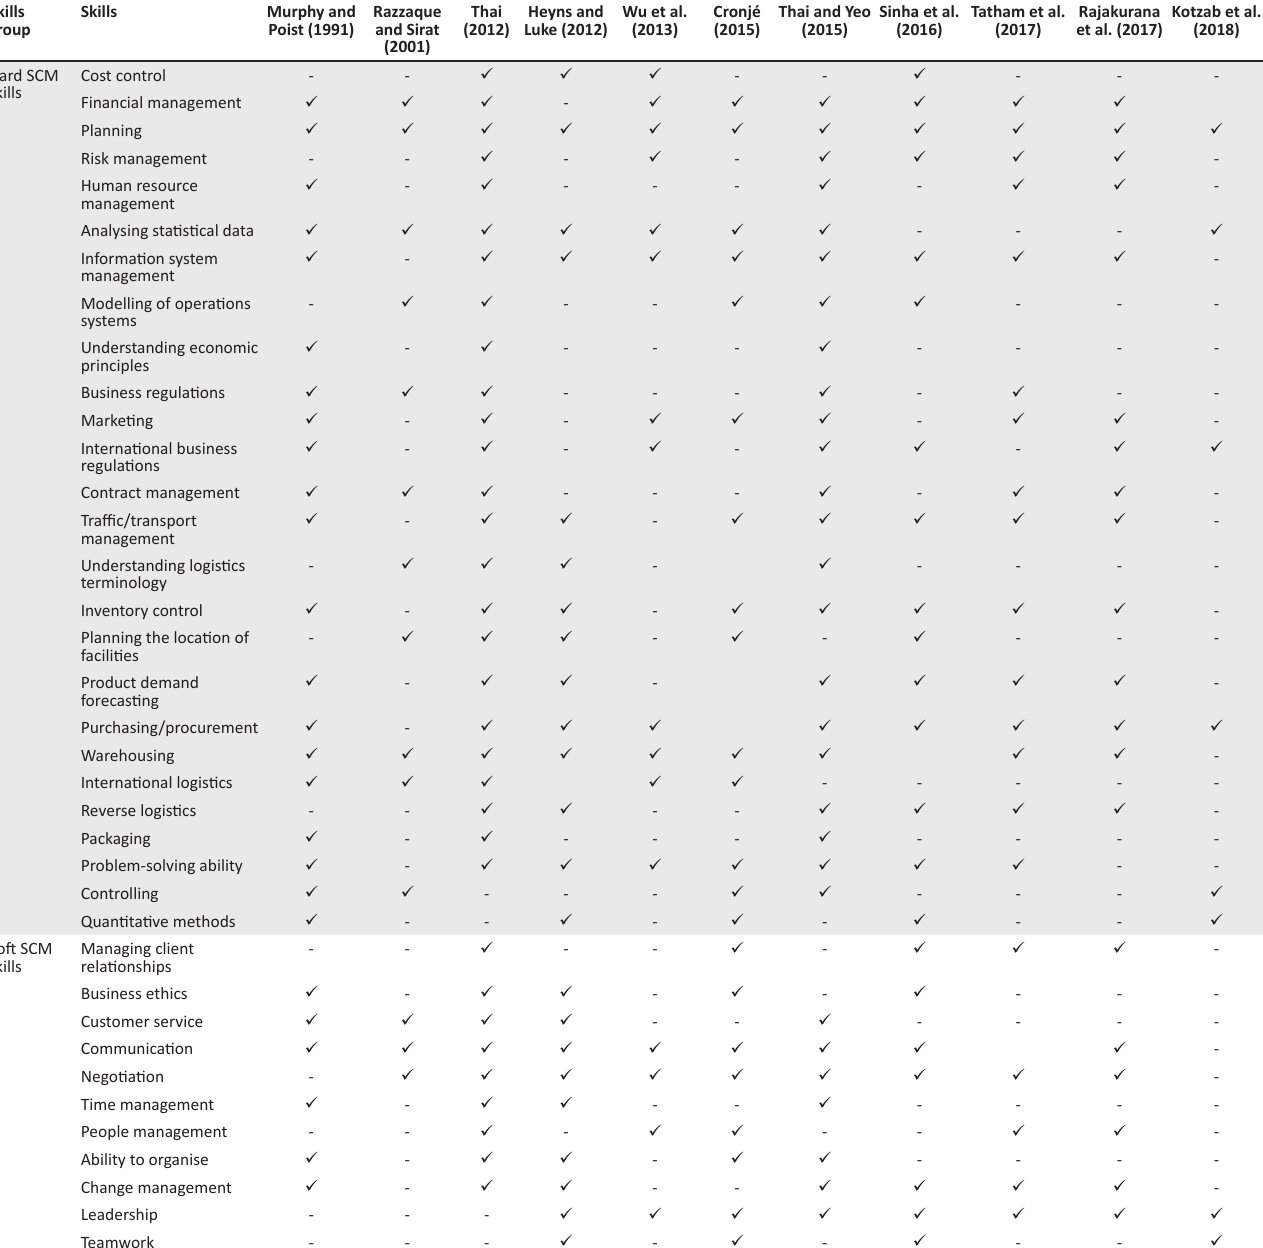
TABLE 1: Supply chain management skills